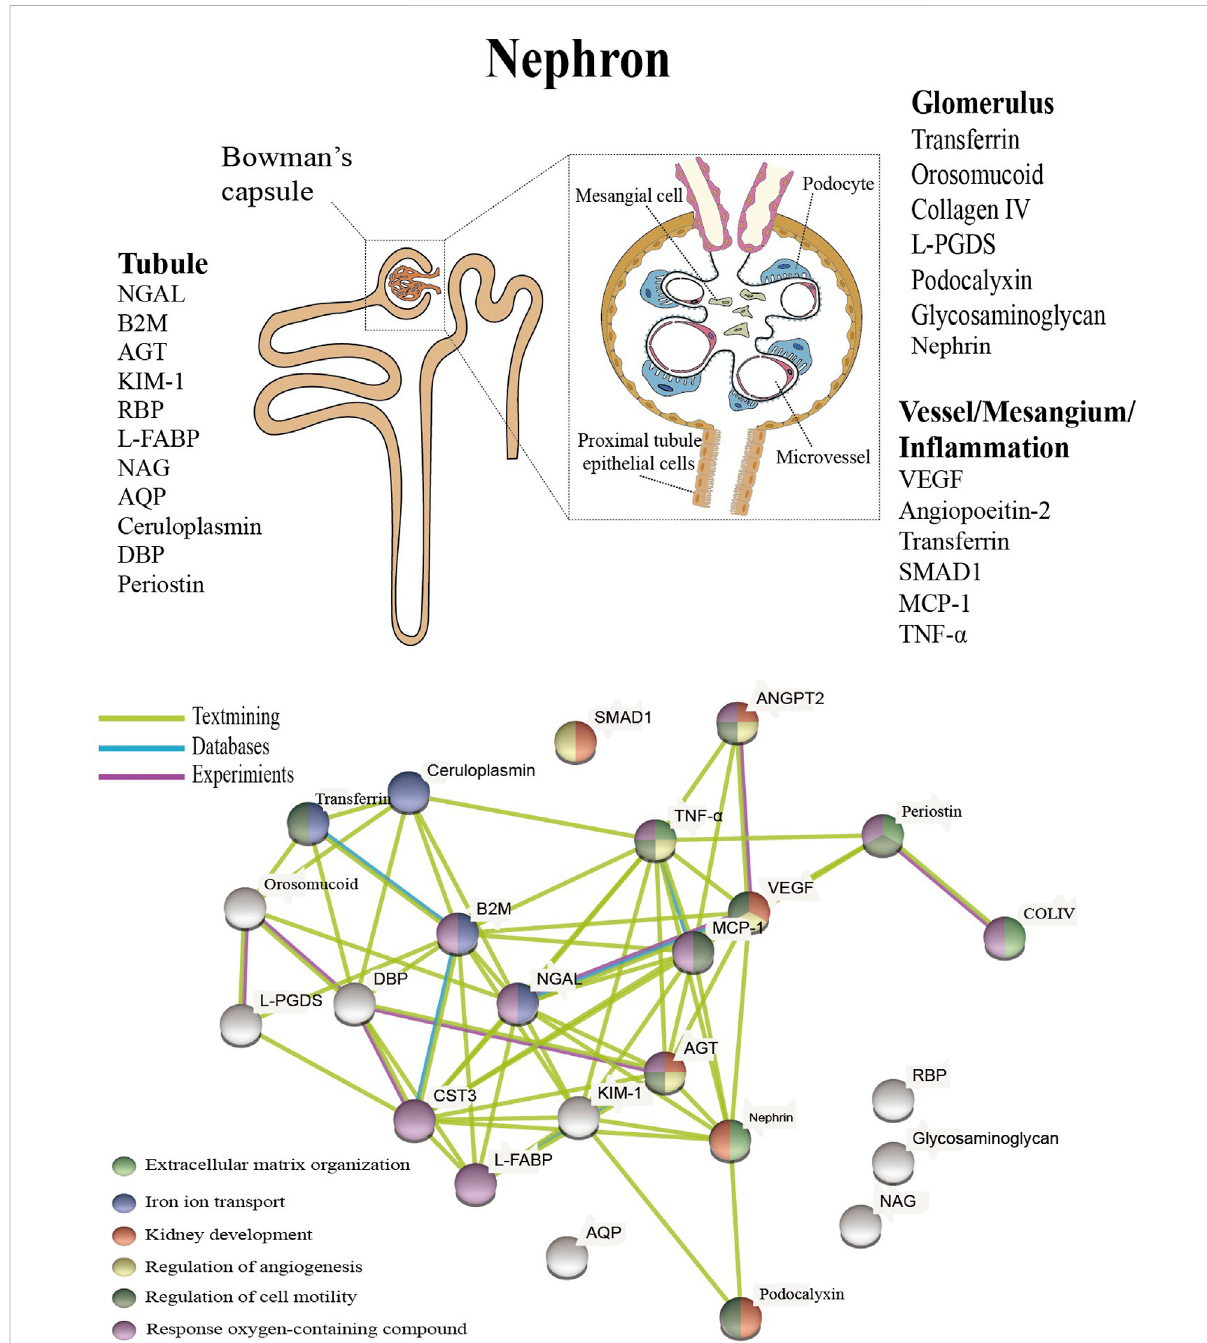
FIGURE 1 Presentation of biomarkers in the nephron (upper) and protein interaction networks and biological processes (below). Abbreviation: NGAL: Neutrophil gelatinase associated lipocalin, B2M: Beta-2-microglobulin, AGT: Angiotensinogen, KIM-1: Kidney injury molecule-1, RBP: Retinol- binding protein, L-FABP: Liver type fatty acid binding protein, COLIV: Collagen IV, NAG: N-Acetyl-B- D -glycosaminidase, ANGPT2: Angiopoietin-2, AQP:Aquaporin,DBP:VitaminDbindingprotein,L-PGDS:Lipocalin-typeprostaglandinD2-synthase,VEGF:Vascularendothelialgrowthfactor, MCP-1: Monocyte chemoattractant protein-1, TNF- α : Tumour necrosis